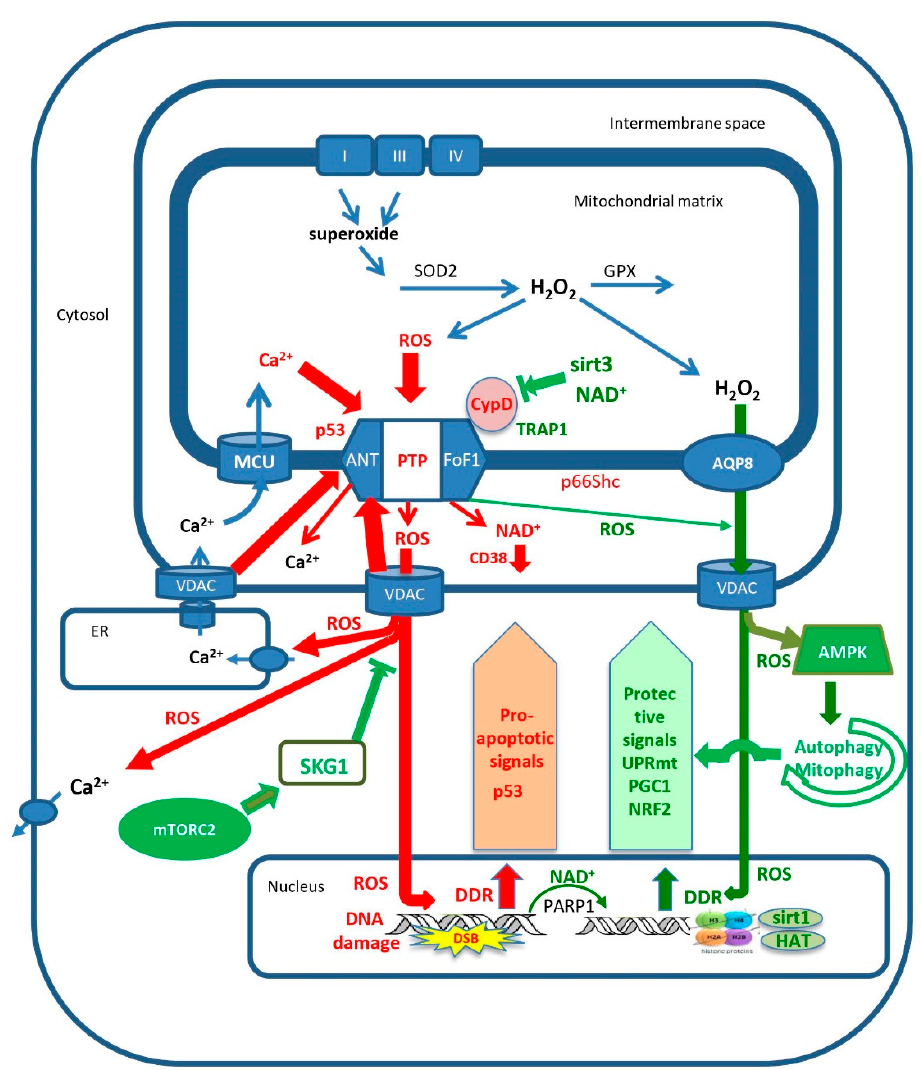
Figure 1. The control of mitochondrial permeability transition pore (mPTP) activity determines the progression of aging. Full opening of mPTP, which is activated by excess mitochondrial calcium loading and/or excess mROS production, releases large amounts of calcium, NAD+ and mROS from the mitochondrial matrix. The released NAD+ is hydrolyzed by CD38, and the loss of NAD+ enhances the progression of aging by inhibiting sirtuins and PARP1. The release of large amounts of mROS causes nuclear DNA damage which enhances apoptotic signaling, such as P53 and p66Shc, further enhancing the activation of mPTP. Additionally, mROS causes oxidative damage to calcium transporters, which enhances excess loading of mitochondrial calcium that, together with the excess release of mROS, activates additional full opening of adjacent mPTP sites. In contrast, modest increases in calcium and/or mROS trigger partial short opening of mPTP, releasing small amounts of mROS that, together with slow diffusion of mROS through AQP8, activate mitochondrial protection mechanisms such as autophagy/mitophagy, UPRmt, NRF2 and PGC1. Additionally, mTORC2 activates SGK1 that inhibits the voltage-dependent anion channel (VDAC) from activating mPTP, enabling autophagy/mitophagy to protect the cell from the progression of aging. Excessive activation of mPTP turns autophagy/mitophagy into a destructive process that leads to cell death. See text for further details.